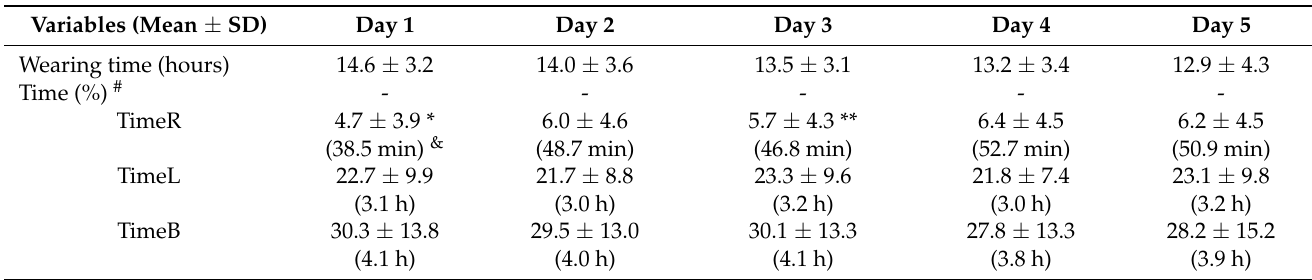
Table 2. Accelerometer wearing time and EMA accumulative measurement reactivity (time metrics for each day). Variables (Mean ±